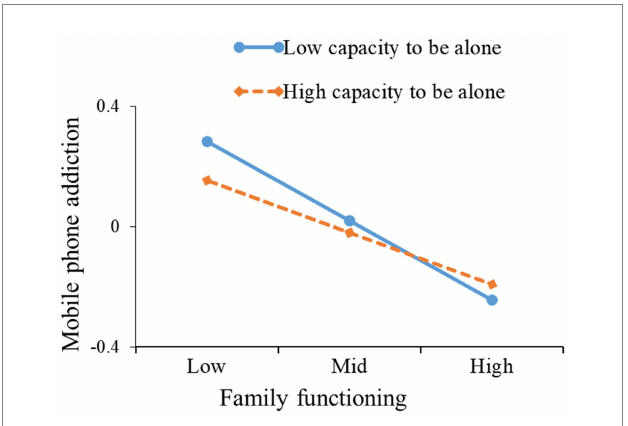
FIGURE 4 The capacity to be alone moderates the relation between family functioning and mobile phone